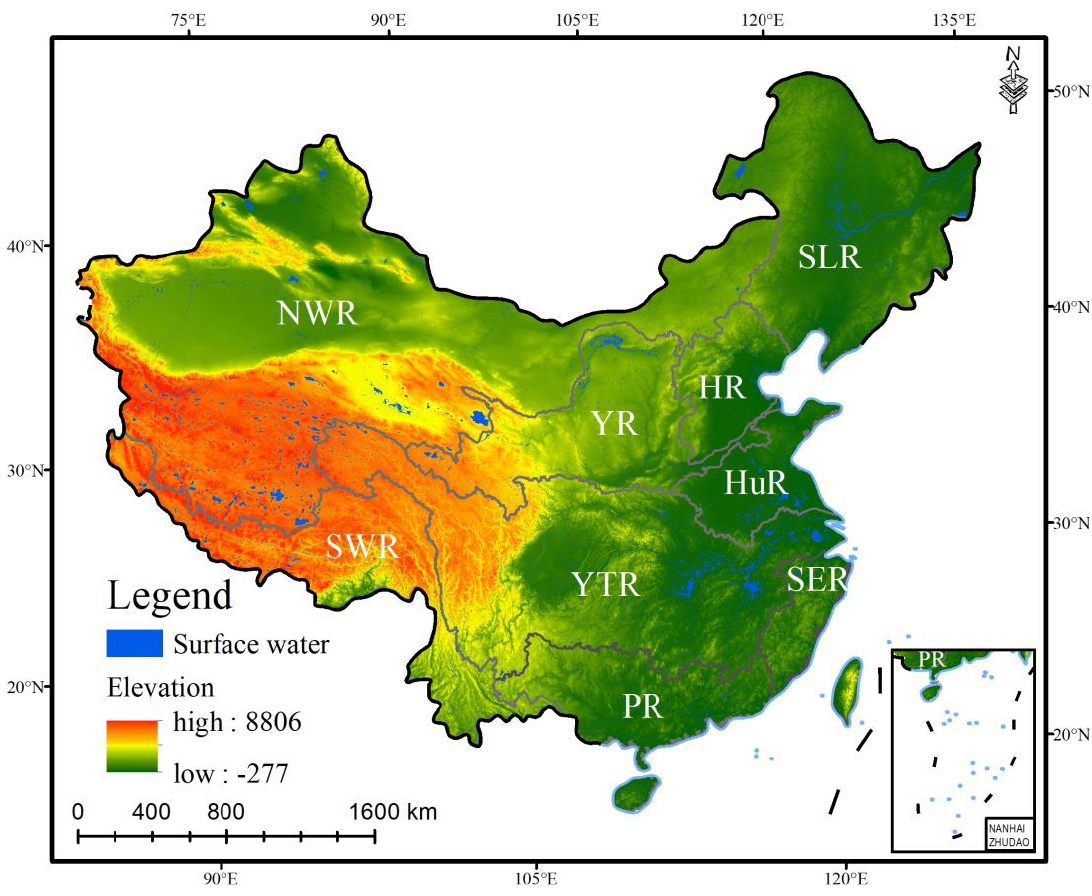
Figure 1. Spatial distribution and zoning of surface water in China. (SER: Southeast River Basin, HR: Hai River Basin, HuR: Huai River Basin, YR: Yellow River Basin, NWR: Northwest Inland River Basin, SWR: Southwest River Basins, SLR: Songliao River Basin, YTR: Yangtze River Basin, PR: Pearl River Basin.).